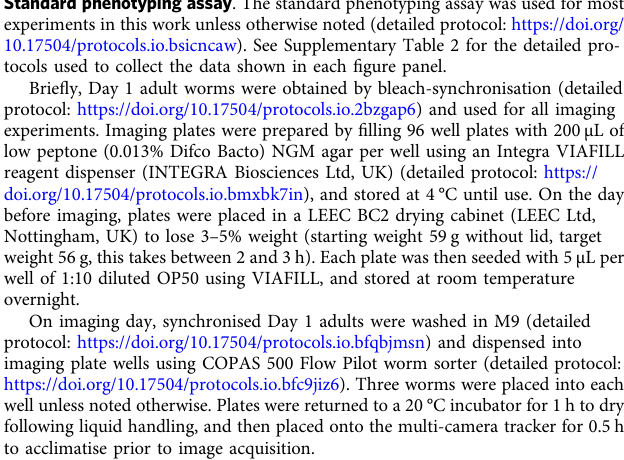
Fig. 3 Escape response to photostimulation. a PCA plots of N2 and CB4856 in the 10 sec immediately before (left) and immediately after (right) a 10 s stimulus showing detectable behavioural responses: both strains moved to new, better separated positions in the phenotype space as a result of stimulation. Sample size (in wells, two worms per well) is N N2 = 377, N CB4856 = 115 (left), N N2 = 398, N CB4856 = 98 (right) b Photostimulation with blue light elicited similar escape responses in both N2 and CB4856 strains, with the fraction of worms moving forwards increasing during the stimulus and decreasing after the stimulus. However, post-stimulus recovery appears to occur at two timescales for N2 but not for CB4856. Solid lines are means, shaded areas show the 95% con fi dence interval. Sample size (in wells, two worms per well) is N N2 = 529, N CB4856 = 396. c Repeated photostimulation triggered increasing aversive response in N2, also leaving a higher fraction of worms stationary after serial stimulation than before (vertical separation between the two dashed lines to contrast the before and the after levels). N = 144 wells (three worms per well). d The fraction of worms triggered to move forwards by each stimulus increased throughout the stimulation series, as a decreasing fraction of worms remained stationary across each successive photostimulus. Each data point was obtained by taking the difference in a 10 s window just before and just after the end of each stimulus. N = 144 wells (3 worms per well). e After repeated photostimulation, a larger fraction of the population than before was stationary. This was quanti fi ed by taking the difference of the population fractions in each motion mode between the fi nal 5 min and the initial 5 min of the experiment (red dashed lines in c ). Each box shows median, 25th and 75th percentile (central mark, lower and upper edge, respectively), while whiskers show the rest of the distribution except for outliers (outside 1.5 times the IQR above the 75th and below the 25th percentile), plotted individually. N = 144 wells (three worms per